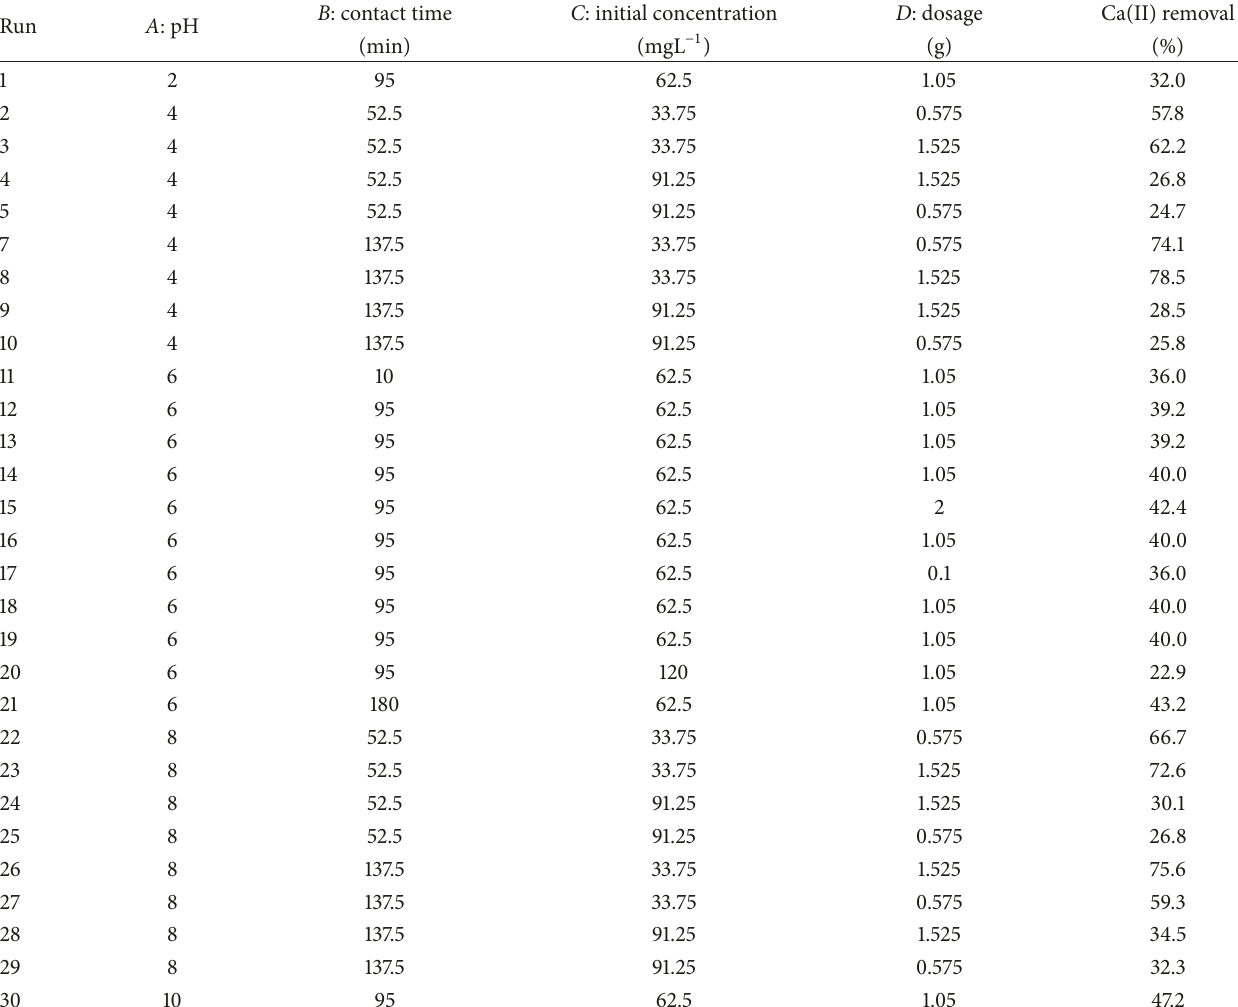
Table 2: Experimental variables and results.